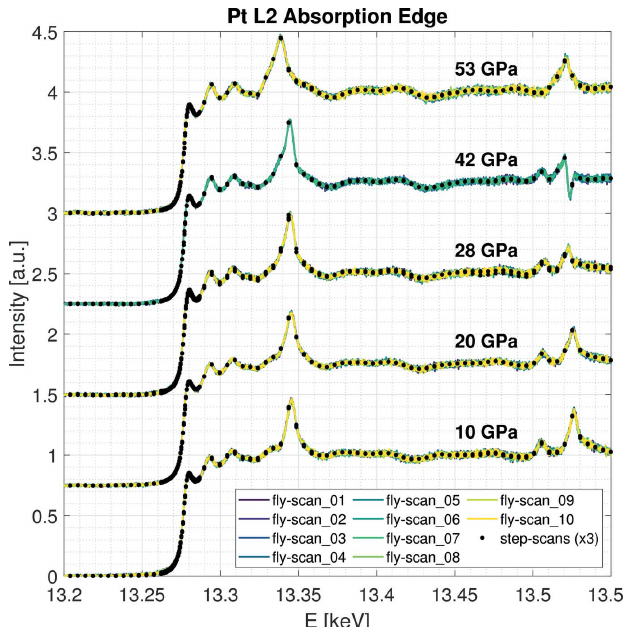
Figure 14 XAS spectra of a Pt foil under multiple high-pressure conditions in a diamond anvil cell setup at EMA, validating a high degree of reliability and repeatability of the HD-DCM and the beamline over hundreds of step- and fly-scan repetitions in a total experimental time around 36 h. Vertical offsets have been introduced for readability. Further discussion is provided in the